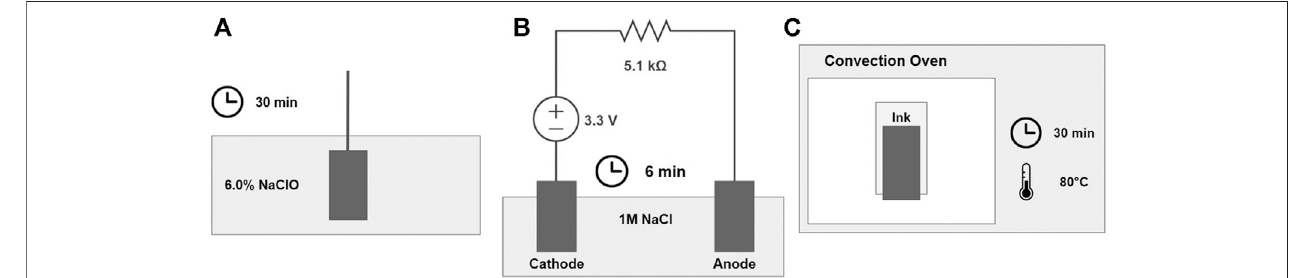
FIGURE 1 | Fabrication schematic for (A) bleach, (B) electroplating, and (C) ink electrodes.